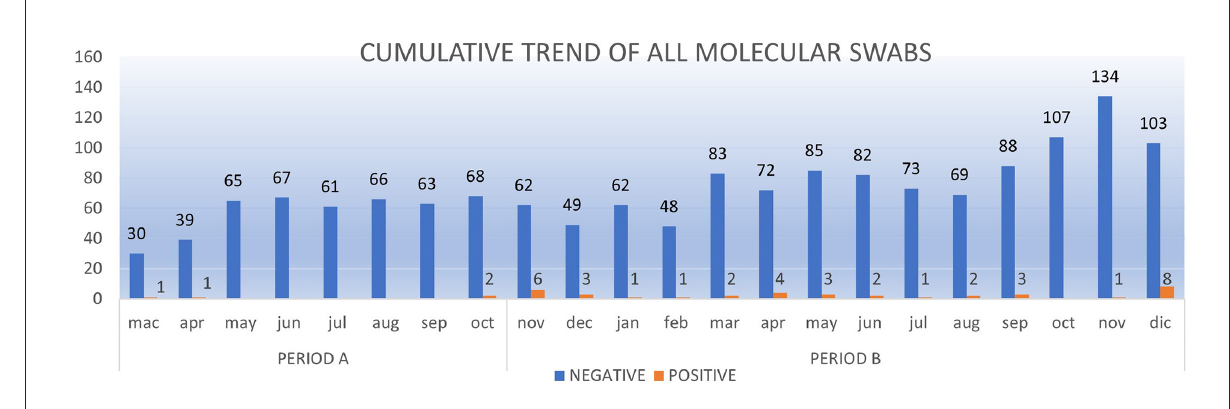
FIGURE3 The cumulative trend of all molecular swabs (RT-PCR) from Mach 1, 2020 to December 31,